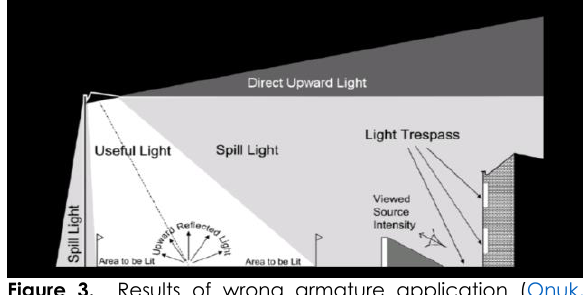
Figure 2. Right and wrong lighting (Dokuzcan, 2006)